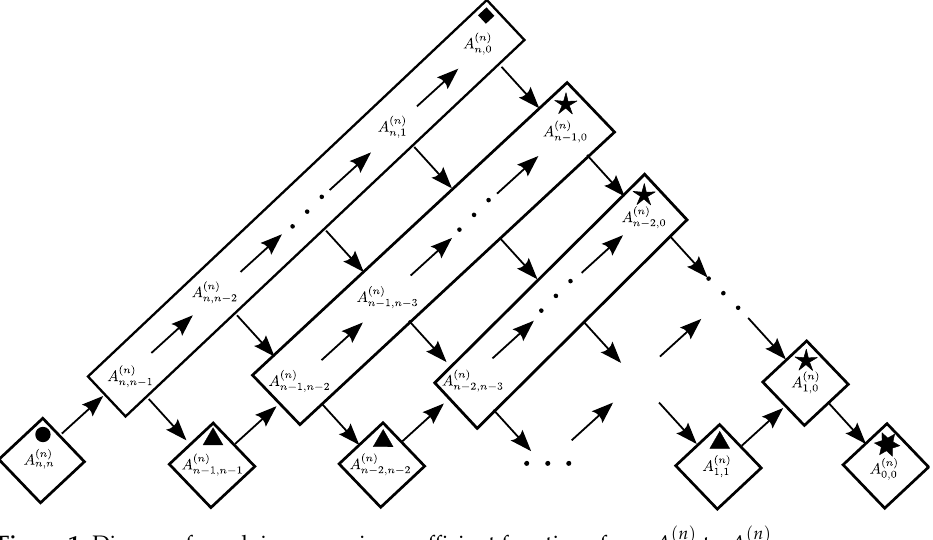
Figure 1. Diagram for solving recursive coefficient functions from A